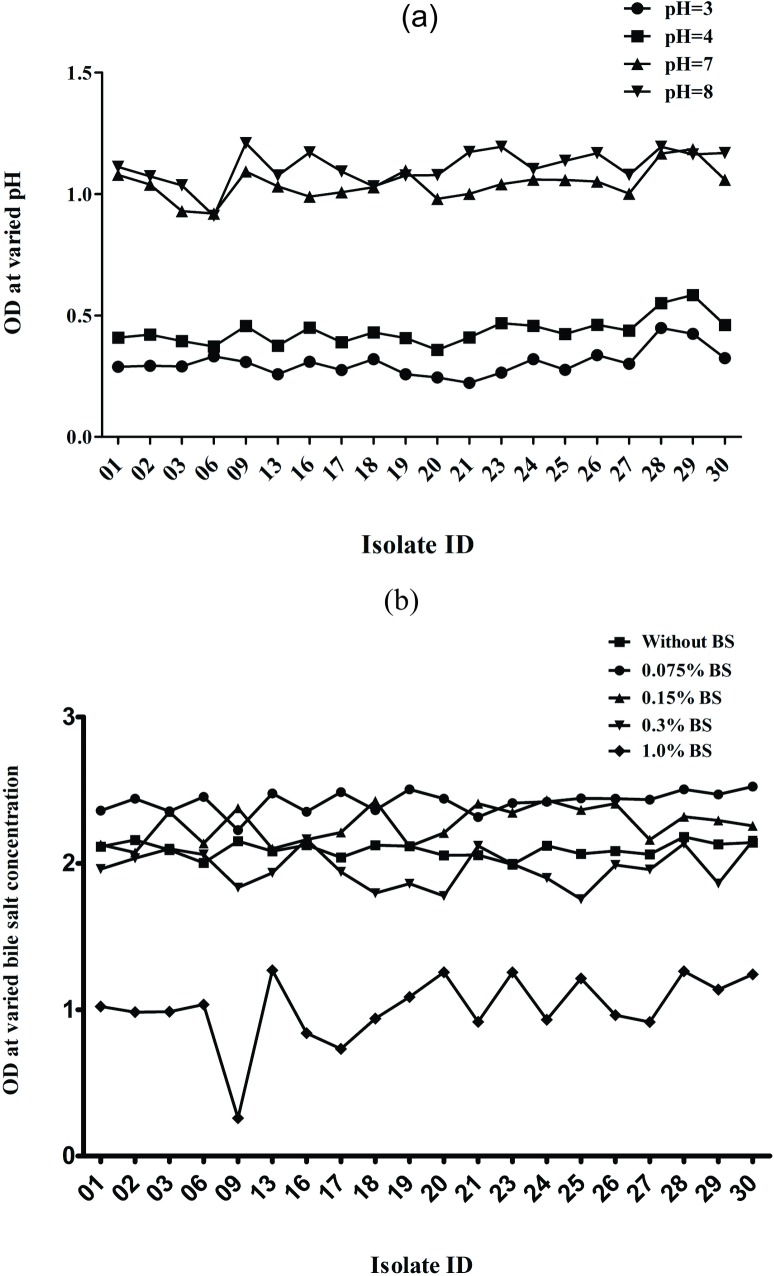
Growth of the LAB isolates (n = 20) at varied pH and bile salt, respectively after 6h incubation at 37°C.